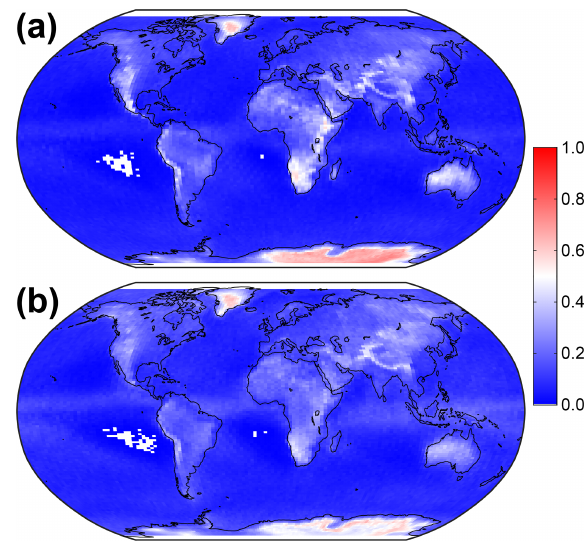
Figure 5. Same as Fig. 4a but separated according to CALIPSO observations during (a) day and (b)